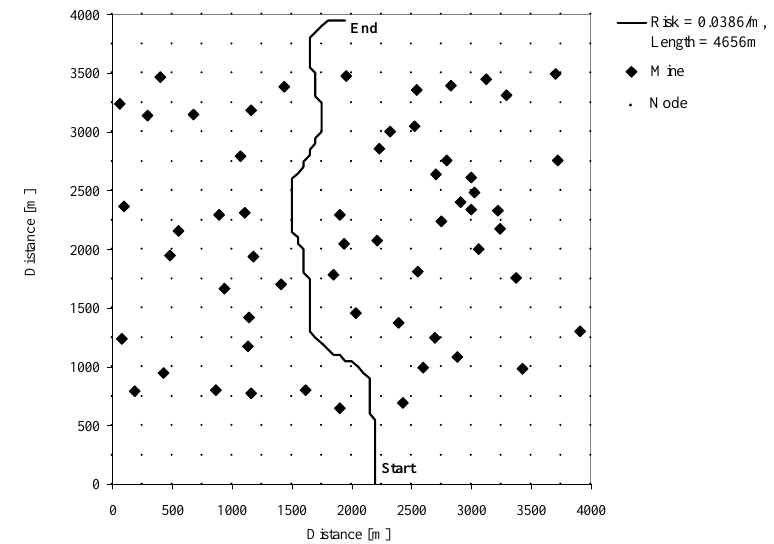
Figure 6: Routes for risk weighting setting = 0%, grid spacing = 50m, safety radius = 0m (for clarity only every fifth grid point is